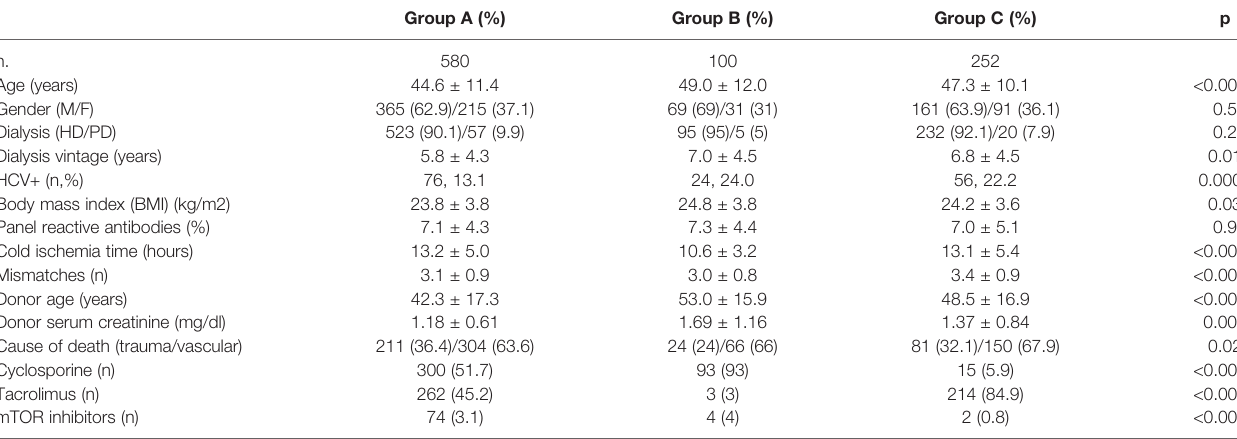
TABLE 4 | The main clinical and demographic characteristics of Groups A, B, and C.